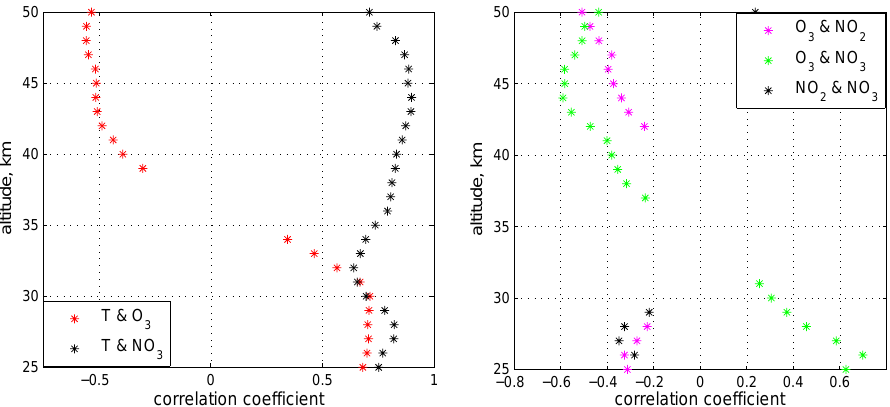
Figure 7 Statistically significant correlations between temperature (MLS and ECMWF) and trace gases (GOMOS) for SSW in years 2003, 2004, and 2006. using all available experimental data and simulations.